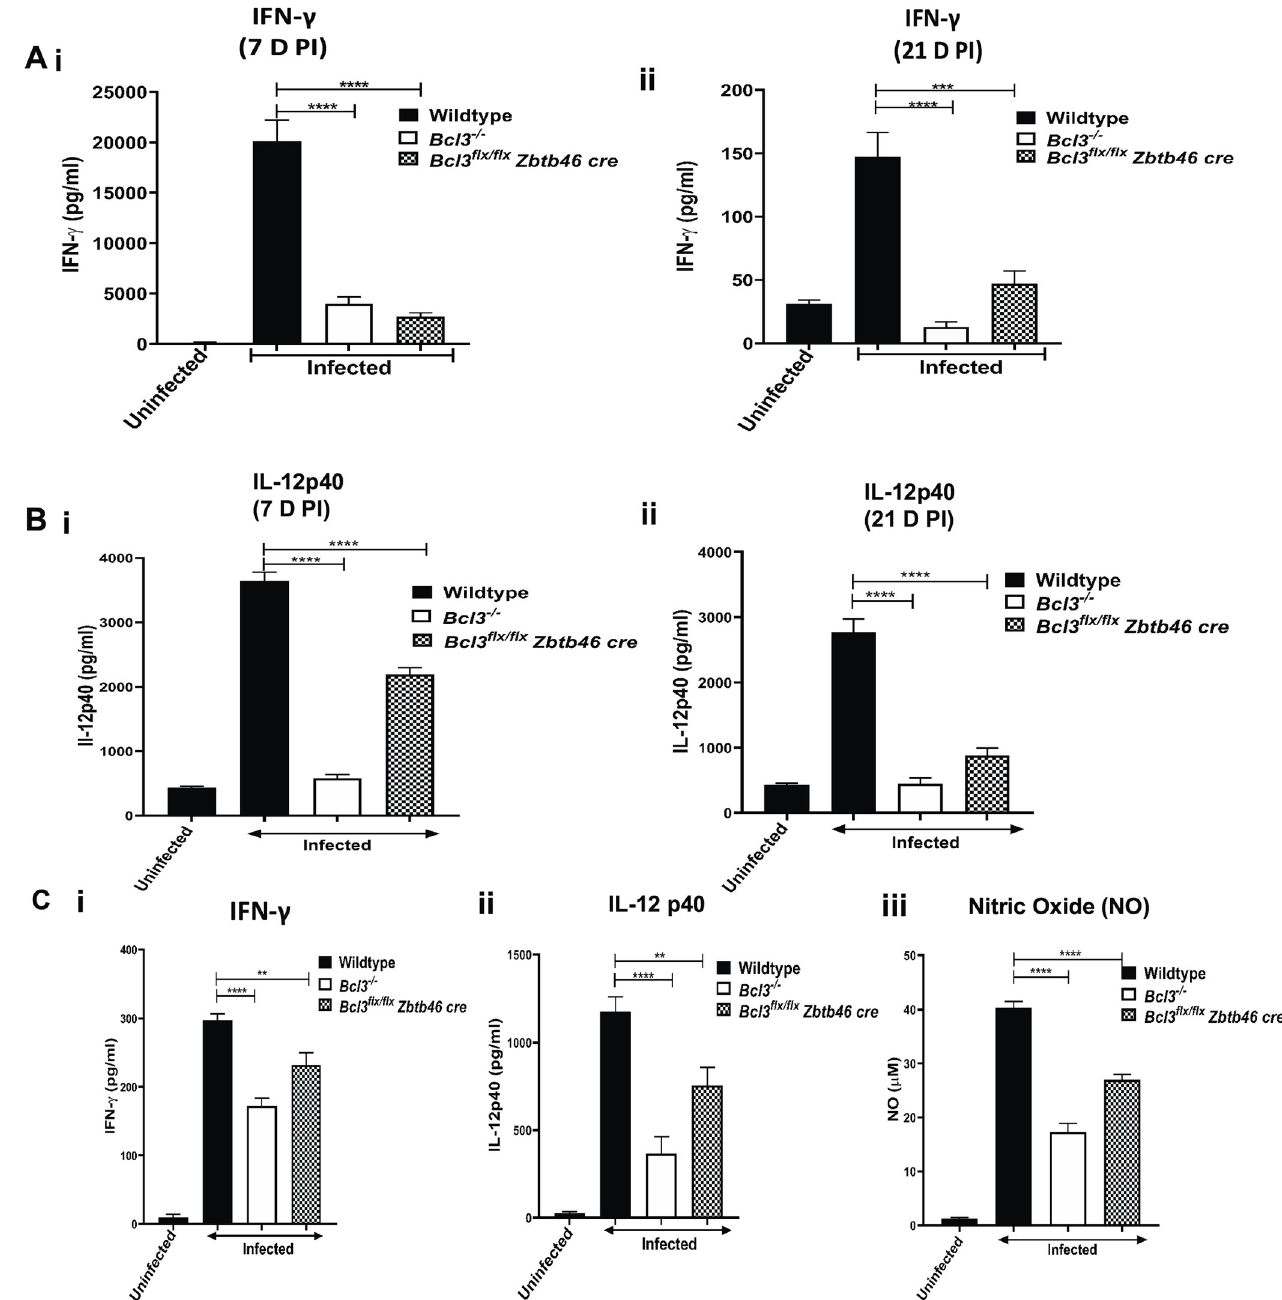
Fig 2. Mice lacking Bcl3 in classical dendritic cells have impaired immune responses to T . gondii infection and an increased parasite load. The indicated mice were infected intraperitoneally with 15 cysts of T . gondii (ME49 strain) and assessed for serum IFN- γ and IL-12 concentration at 7 D PI (Ai, Bi) and 21 D PI (Aii, Bii). In panel C, splenocytes from uninfected and infected mice were stimulated ex vivo 7 days PI with STAG (5 mg/ml) for 72 hours. Supernatants were collected and IFN- γ (i), IL-12 p40 (ii) and nitric oxide (iii) levels were determined by ELISA. Data are shown as the mean ± SEM, n = 3 for uninfected mice and n = 9 for all infected groups, which were pooled from 3 independent experiments. Student‘s unpaired t test was used for statistical analysis. �� p < 0.01, ��� p < 0.001, ���� p < 0.0001.